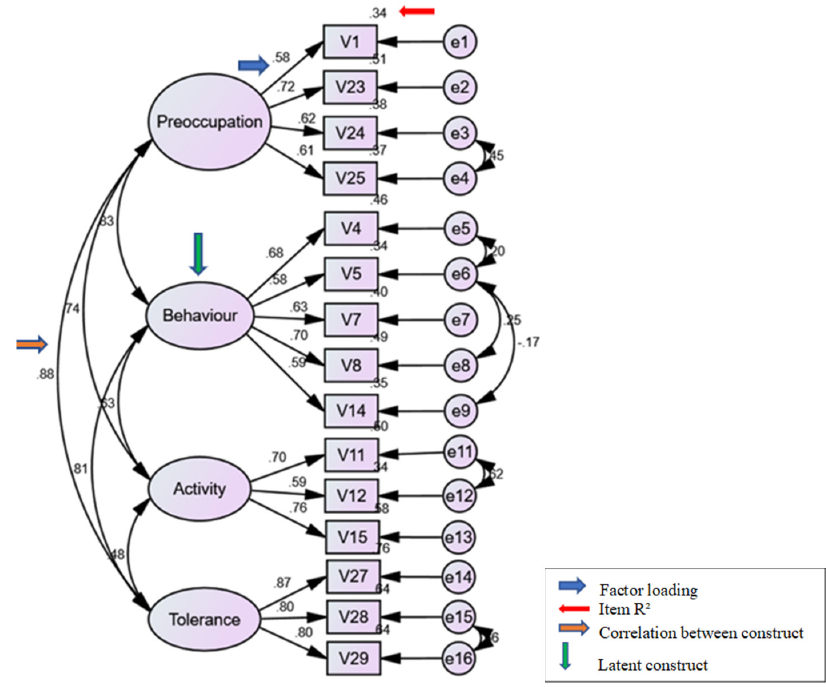
Table 2. Summary of the Screen Dependency Scale’s goodness of fit.